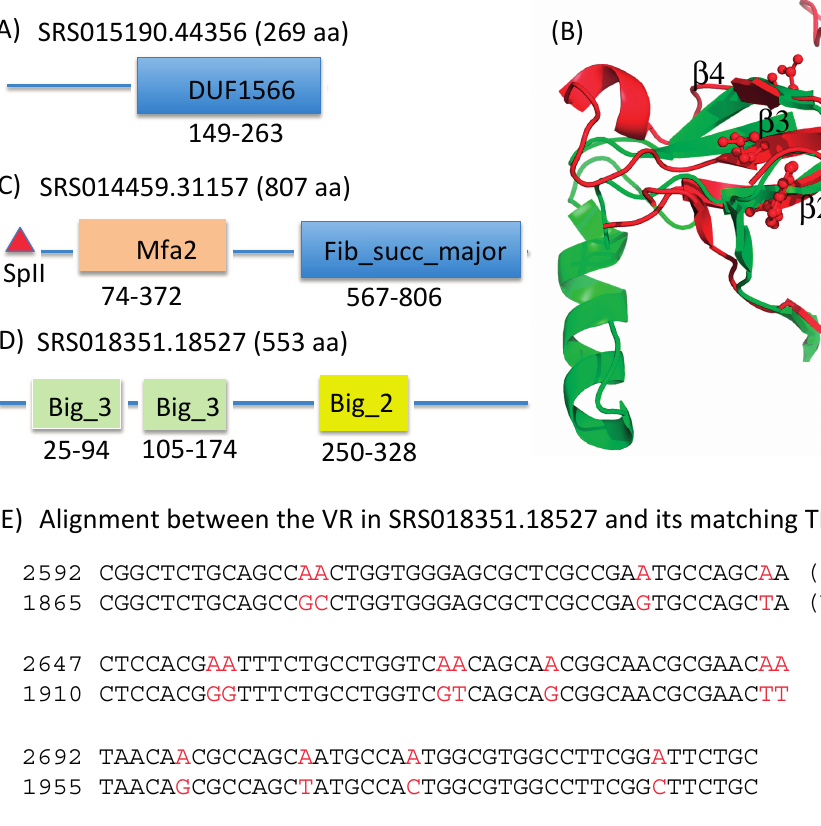
Figure 4. Representative variable proteins identified from the HMP datasets. ( A ) SRS015190.44356 with a DUF1566 domain; ( B ) Superimposition between 2Y3C (TvpA; shown in red) and 4EPS (green); ( C ) SRS014459.31157, a predicted lipoprotein with Mfa2 (shown in bisque) and Fib_succ_major (blue) domains; ( D ) The domain architecture of SRS018351.18527 with bacterial immunoglobin-like domains; and ( E ) the alignment between the VR region in this gene and the matching TR, which contains 15 substitutions (highlighted in red), all involving adenines in the template region.